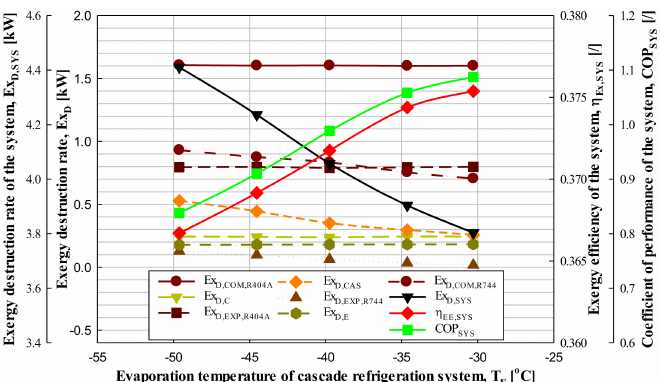
Figure 8. Exergy destruction rate, exergy efficiency and COP of the CRS with respect to the evapora- tion temperature of the